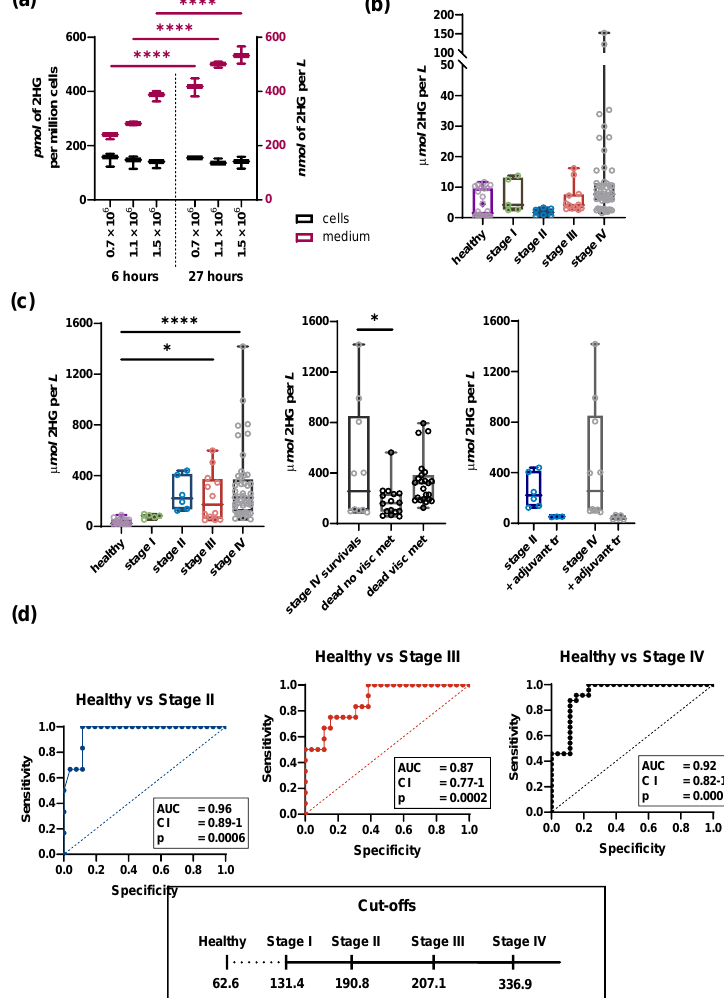
Figure 5. 2HG release from cells and tumors. ( a ) 2HG levels released in medium (magenta) versus cell lysates (black) at the indicated cell density and time frame. ( b ) 2HG concentration in serum of the breast cancer patients and healthy volunteers. n > 5. ( c ) Left: 2HG concentrations in the urine of the breast cancer patients and healthy volunteers. n > 5. One-way ANOVA. Middle: Urine concentrations of the patients in stage IV; including with or without visceral metastases ( visc met ). Right: Urine concentrations of the patients in stages II and IV, respectively, indicating the second estimation after 1 or 6 months of anti-HER2 treatment with Trastuzumab and chemotherapy. ( d ) ROC curves of the urine 2HG levels and calculated cut-off values. * p < 0.05 **** p <0.0001